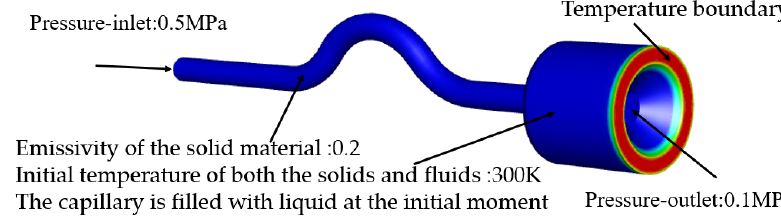
Figure 5. Setting of parameters for capillary flow simulation at the initial moment. The physical properties of ADN-based liquid propellant (mass-to-fraction ratio of ADN, H2O and methanol is 63%:26%:11%) are shown in Table 3. Table 3. Properties of ADN-based liquid propellants.